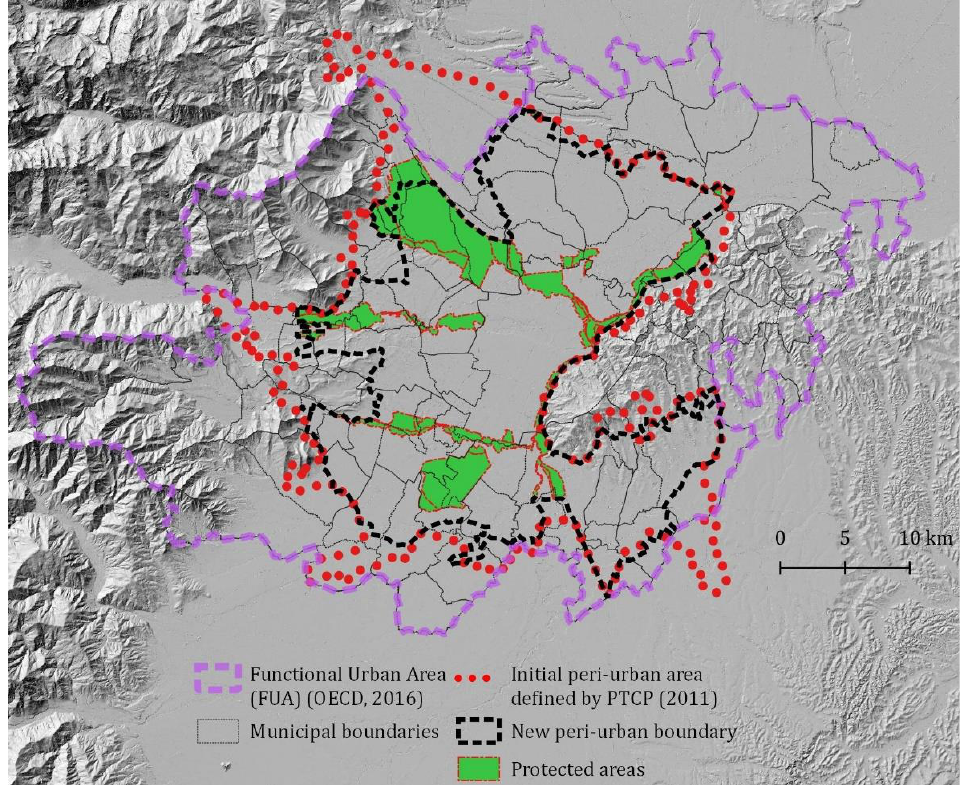
Figure 3. The perimeter of the Turin peri-urban area defined in relation to the discontinuity cells within the presumed peri-urban area and taking into account the proximity to the city center (buffer 15 km).